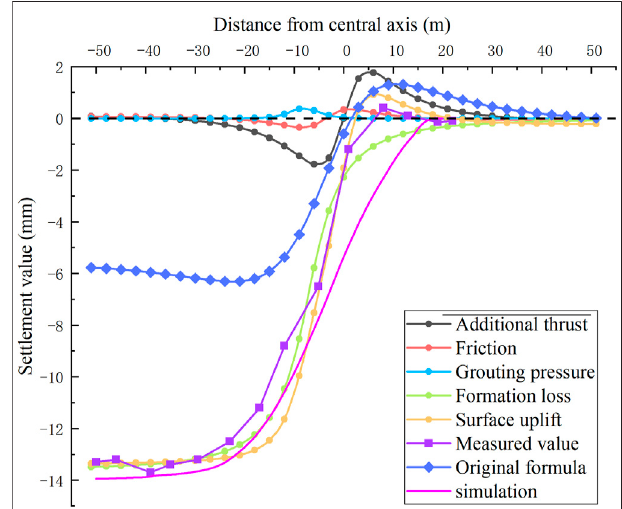
FIGURE 9 | Longitudinal surface deformation of Section 1 .